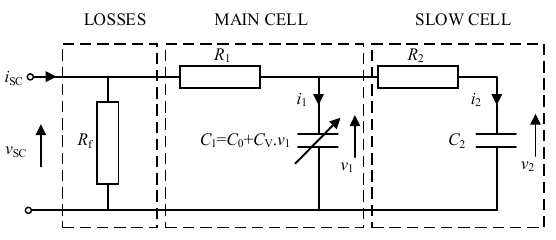
Figure 2. A simplified model of the supercapacitor.